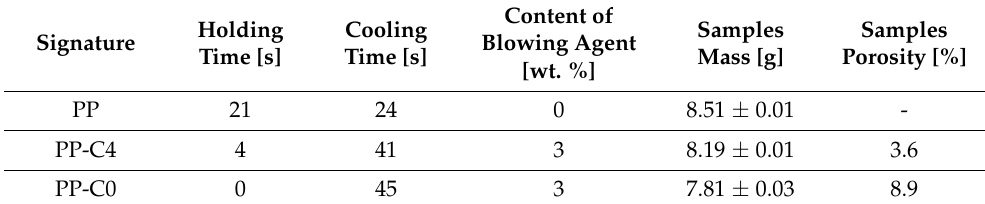
Table 1. Sample markings and selected process parameters.